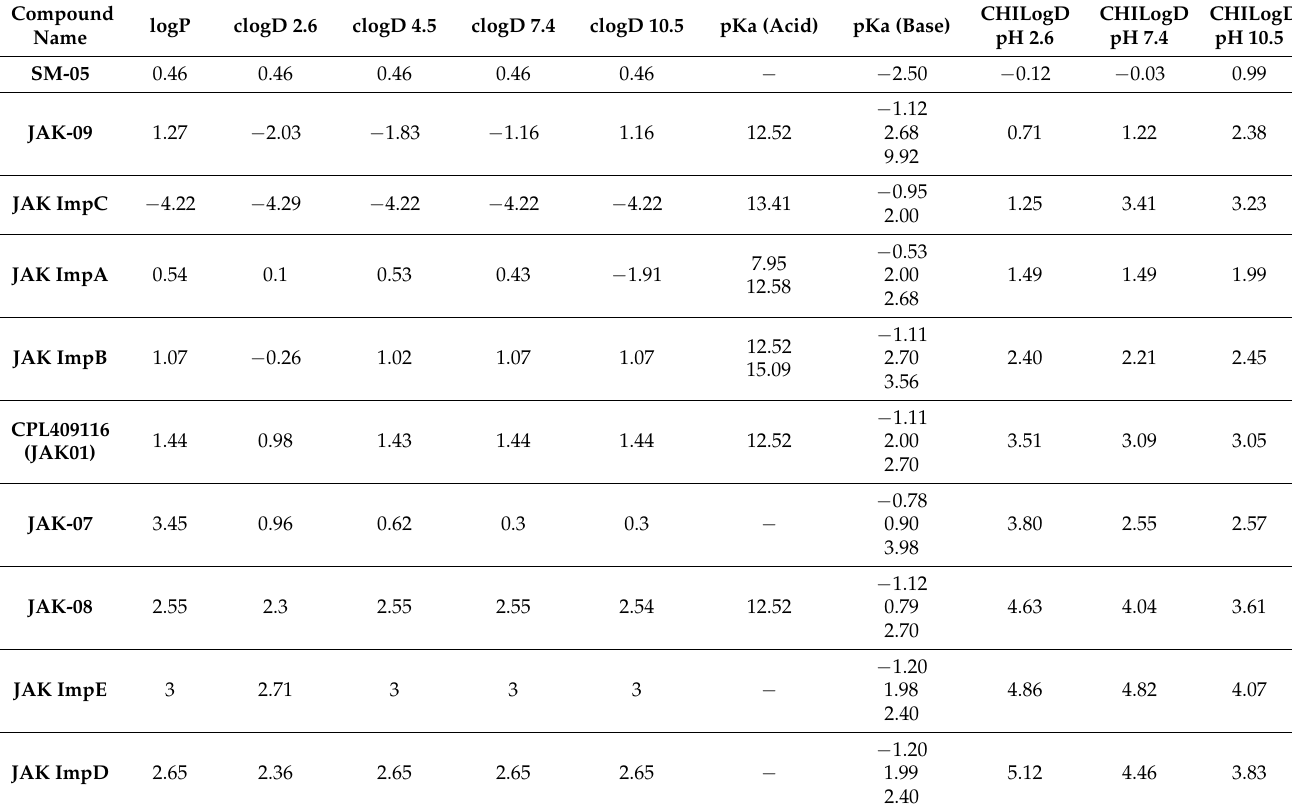
Table 1. Calculated physico-chemical properties and determined the chromatographic hydrophobicity index CHI logD of CPL409116 and its